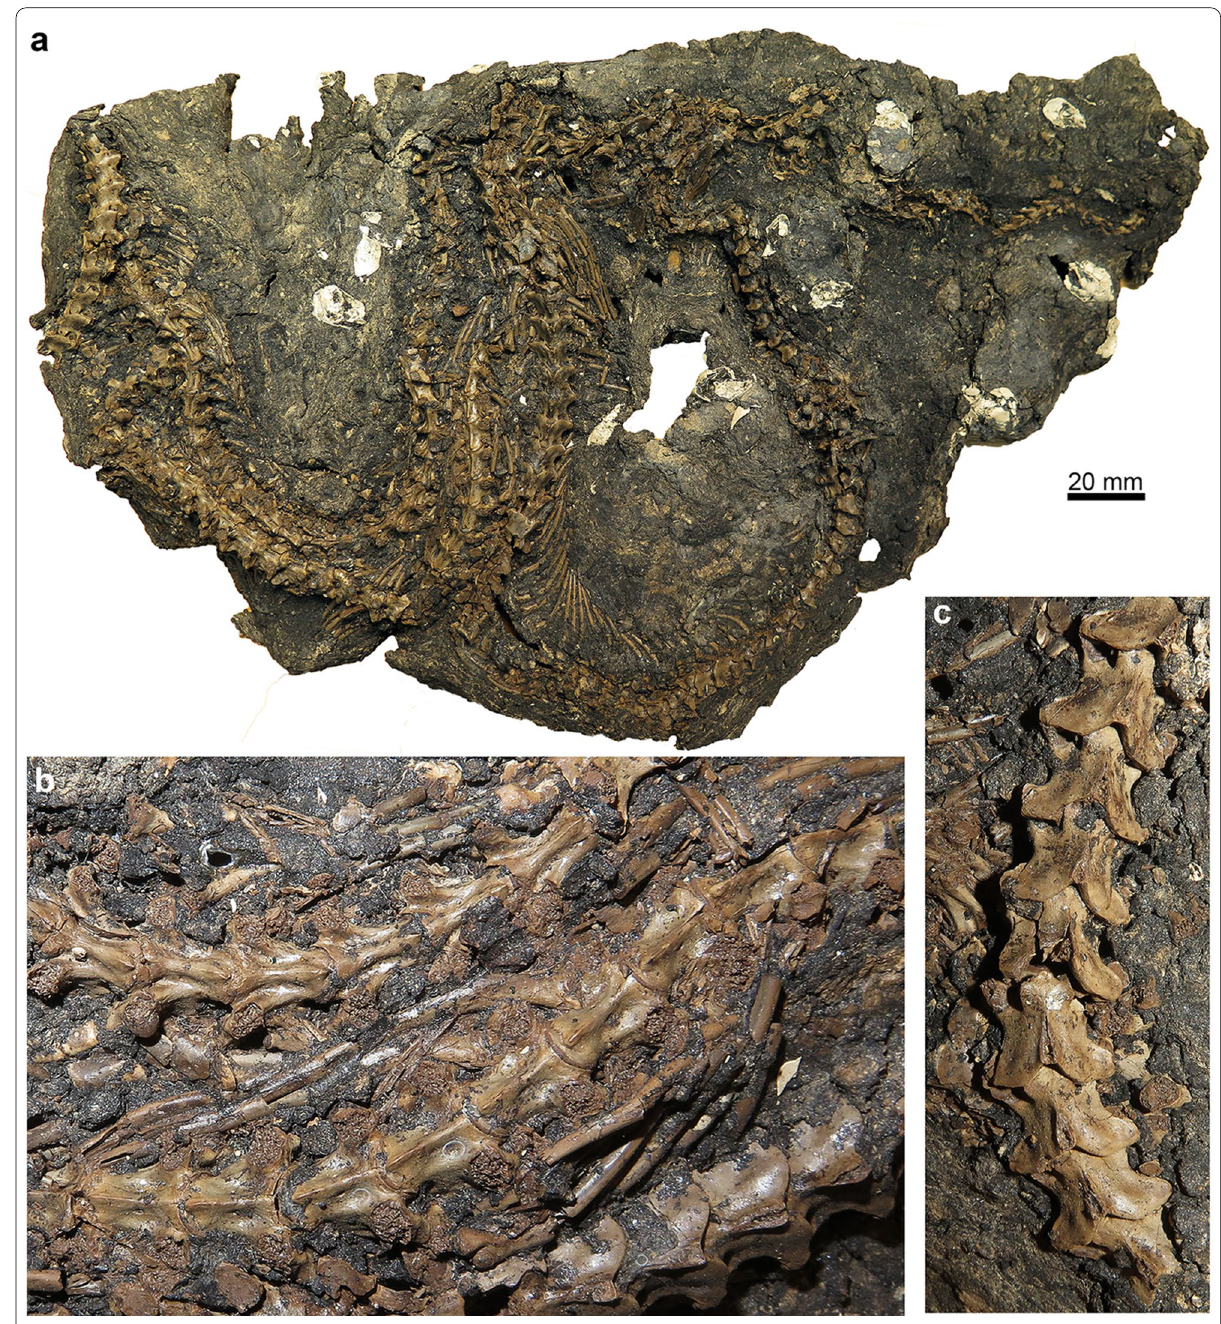
Fig. 61 Eoconstrictor cf. fischeri from quarry XXXVI, Geiseltal: a partial skeleton with many articulated vertebrae and ribs (GMH XXXVI-87-1962); b , c close up photographs of several articulated vertebrae and ribs of the same specimen. Specimen originally figured by Krumbiegel et